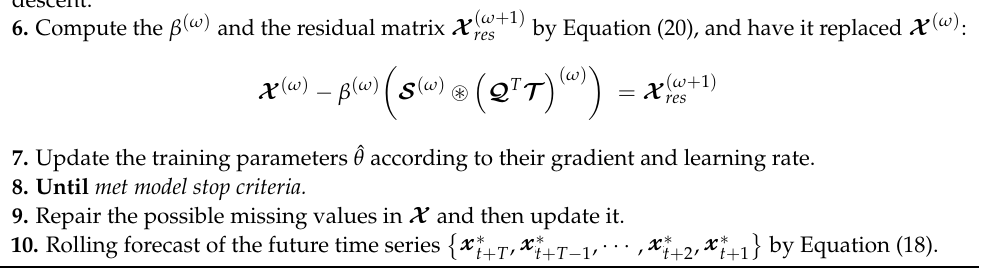
Figure 1. Illustration of multivariate time series forecasting (each 𝔁 (cid:3047) is a frame of traffic data at time step 𝑡 ).